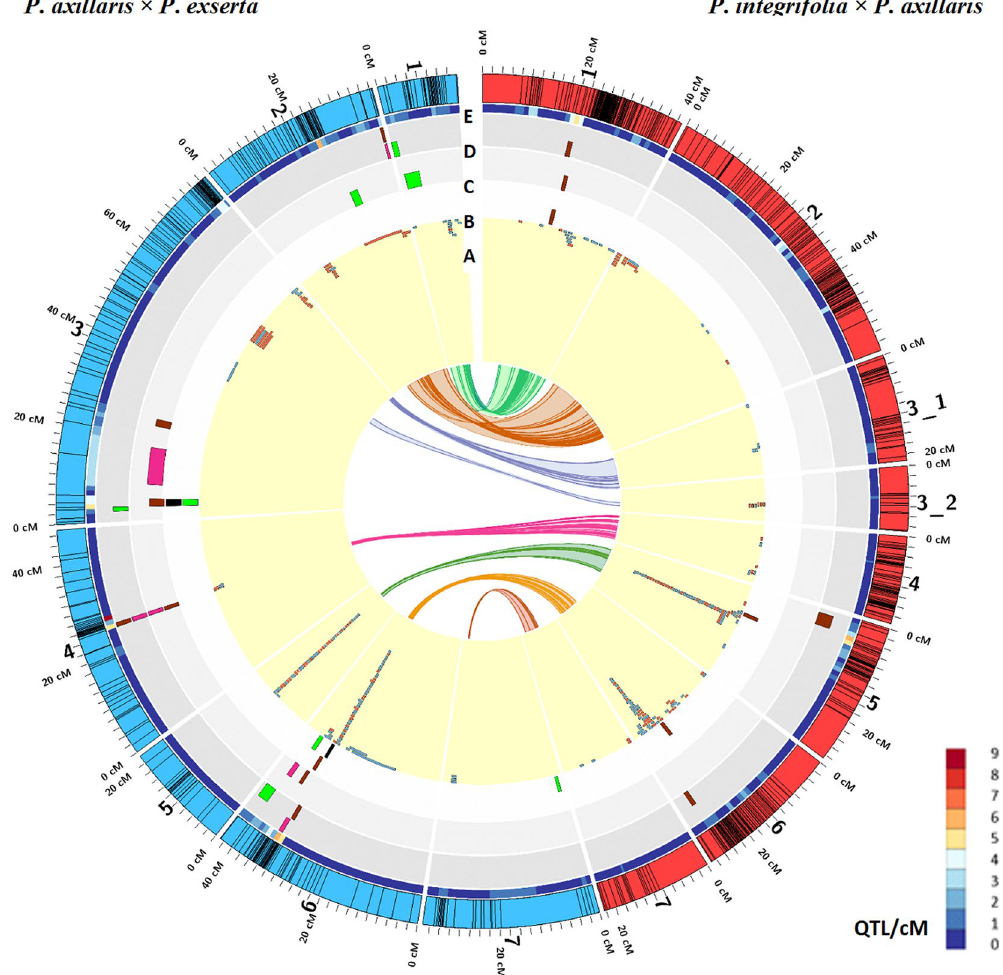
Figure 3. QTL detected for development rate and the differentially expressed genes between “fast” and “slow”- developing RILS on the linkage groups of P . integrifolia × P . axillaris (IA) and P . axillaris × P . exserta (AE) populations. Rings represent: ( A ) Differentially expressed IA genes mapped to each population; the genes highlighted in red and blue are up-regulated and down regulated genes, respectively. QTL for development rate identified at 14 °C ( B ), at 17 °C ( C ) and 20 °C ( D ). ( E ) Heat map showing the overall QTL density along each linkage